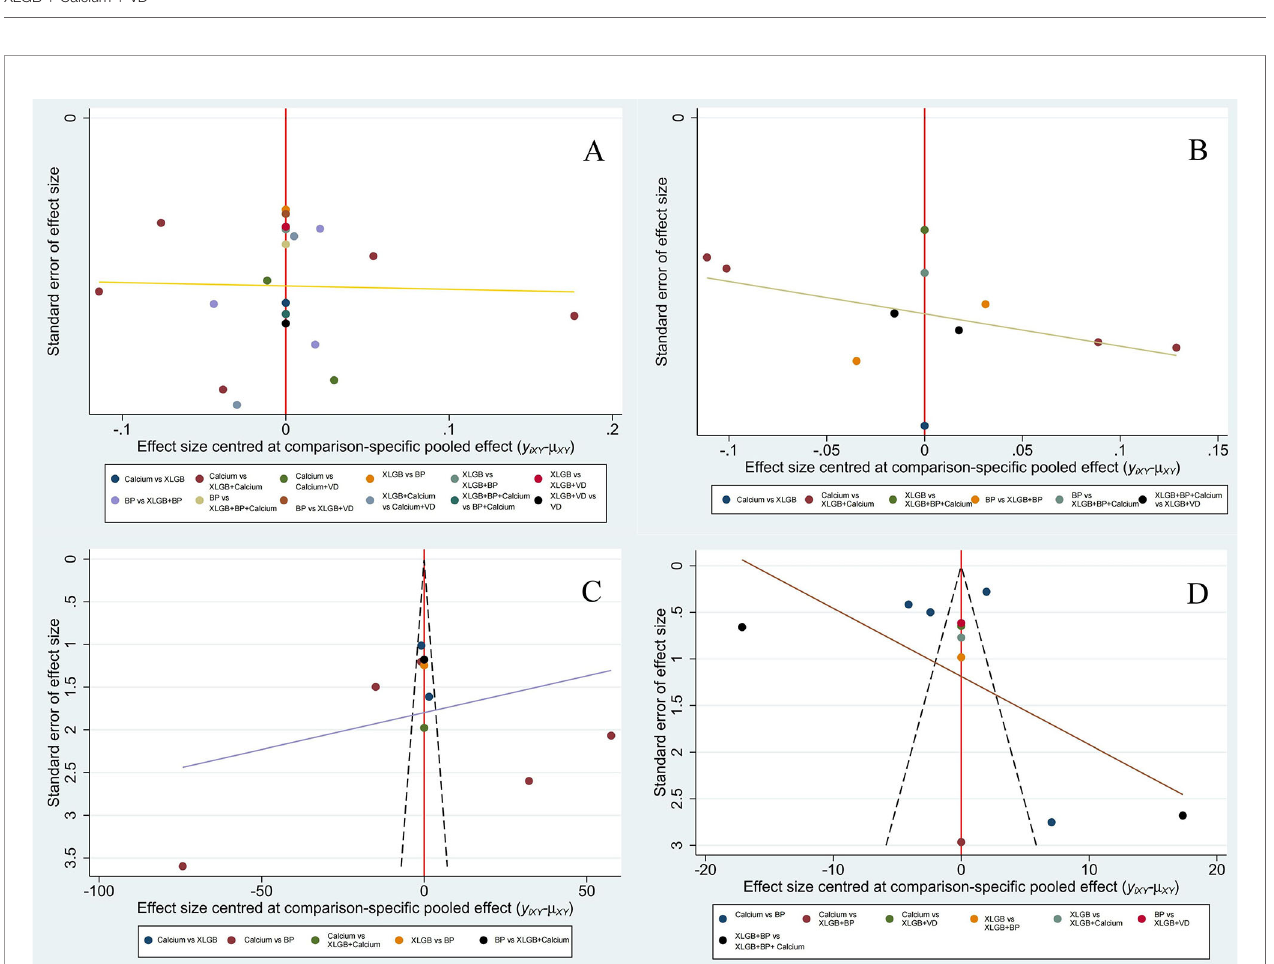
Frontiers in Endocrinology |